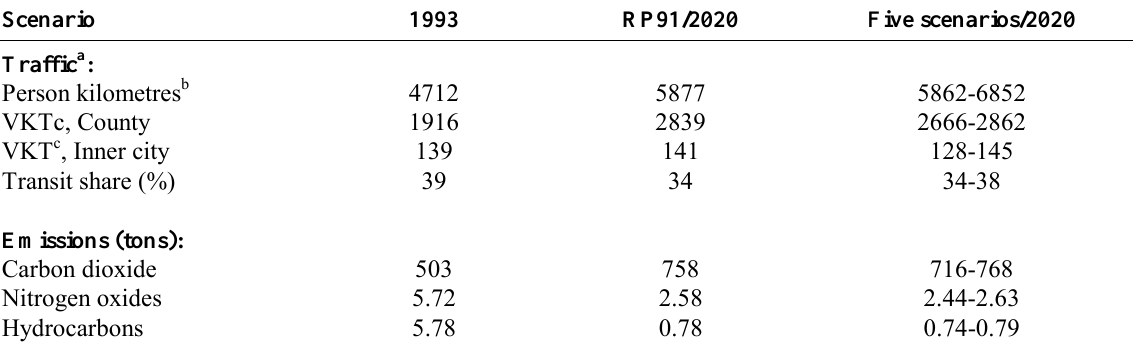
Table 1. Regional structures: long-term projections of traffic and environment